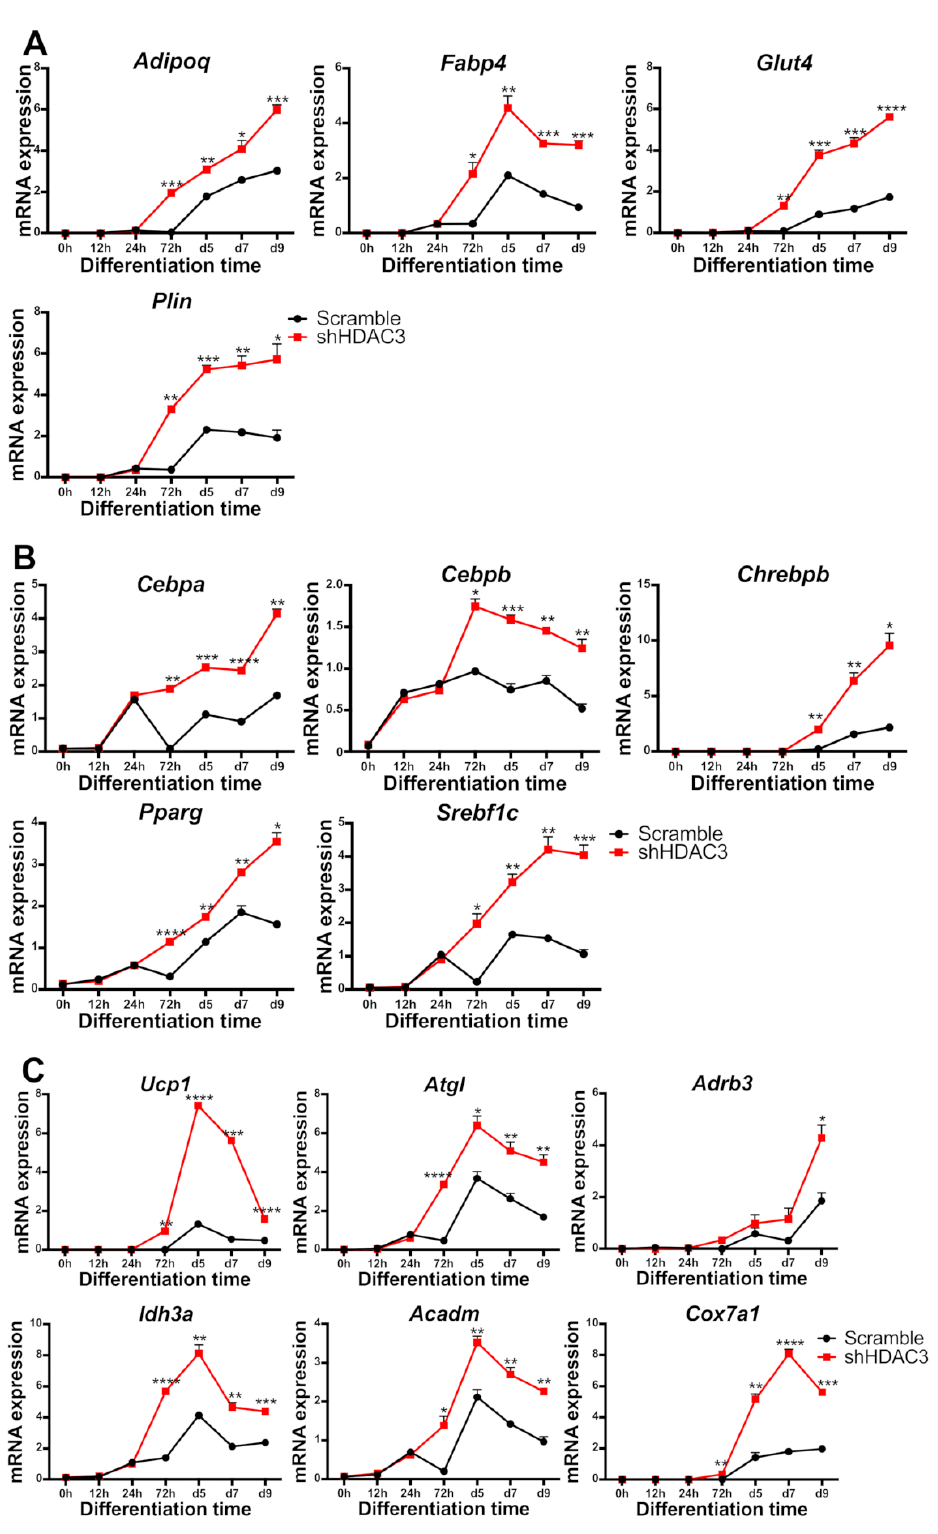
Figure 9. Kinetics of gene expression in C3H/10T1/2 cells infected with scramble/shHDAC3 and induced to differentiate to adipocytes. Expression of genes involved in adipocyte functionality ( A ), differentiation ( B ) and browning and mitochondrial oxidative metabolism ( C ). Data are presented as mean ± SEM of triplicate wells. Statistical analyses were performed using unpaired Student’s t -test, * p < 0.05, ** p < 0.01, *** p < 0.001, **** p <